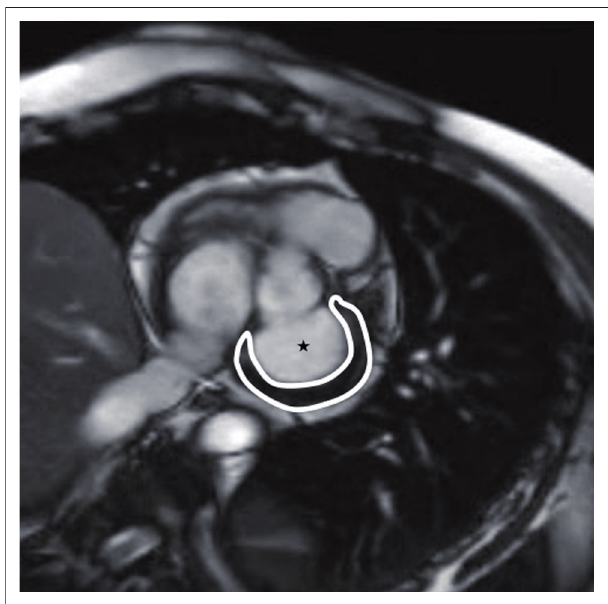
FIGURE 4: Single short-axis cine SSFP image of the basal LV myocardium. The basal slice is the first slice where the blood pool ( * ) is encircled by more than 180 degrees of myocardium (white contour).